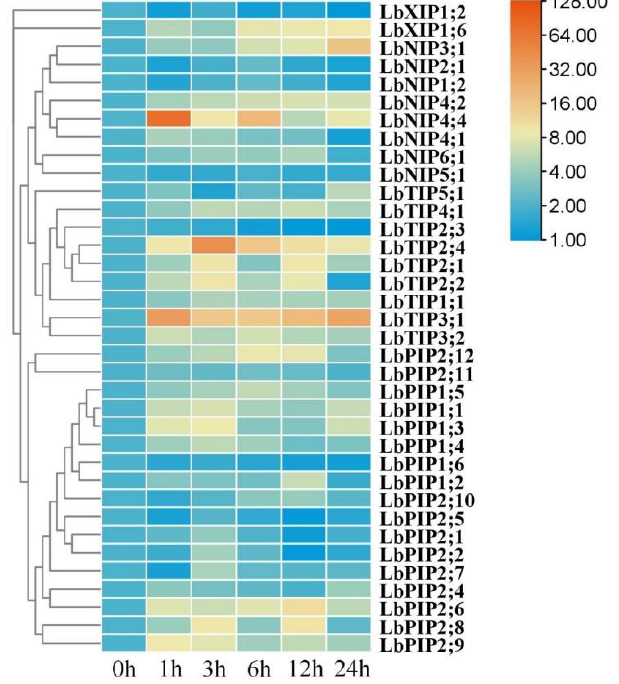
Figure 8. Expression profiling responses to heat stress. The expression levels of LbAQPs were measured in the leaves of 2-month-old L. barbarum subjected to 42 °C for 0, 1, 3, 12, or 24 h. The fold changes in the relative expression levels were analyzed via the 2 −ΔΔ CT method using the LbACTIN1 gene as an internal control. Values are the means of three independent experiments.